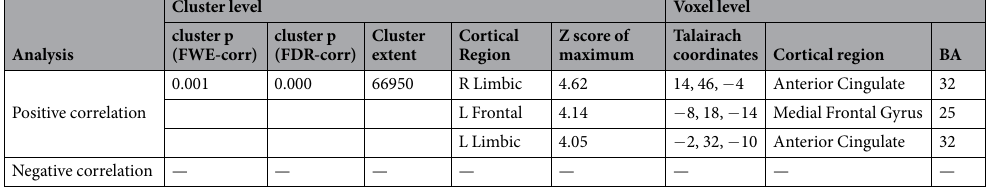
Table 3. Multiple regression analysis showing the TSH related areas of increased 18 F FDG brain uptake. In the ‘cluster level’ section on left, the number of voxels, the corrected P value of significance and the cortical region where the voxel is found, are all reported for each significant cluster. In the ‘voxel level’ section, all of the coordinates of the correlation sites (with the Z-score of the maximum correlation point), the corresponding cortical region and Brodmann Area are reported for each significant cluster. L, left; BA, Brodmann’s area. In the case that the maximum correlation is achieved outside the grey matter, the nearest grey matter (within a range of 5 mm) is indicated with the corresponding BA.